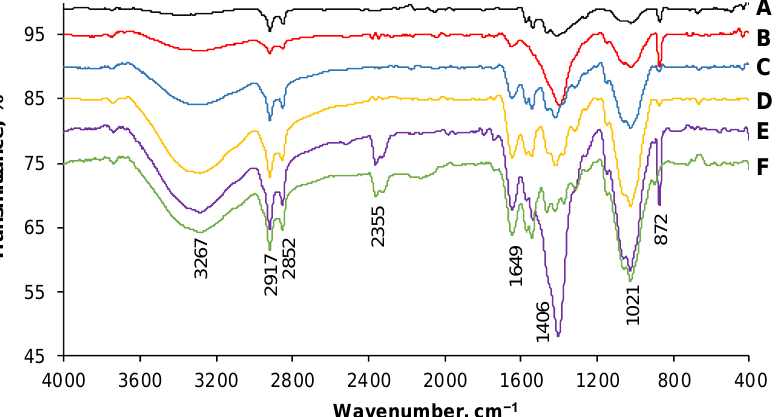
Figure 4. FTIR spectra of CSCH beads before dye adsorption ( A ) and after adsorption of AR ( B ), RB ( C ), 25% AR + 75% RB ( D ), 50% AR + 50% RB ( E ), and 75% AR + 25% RB ( F ).